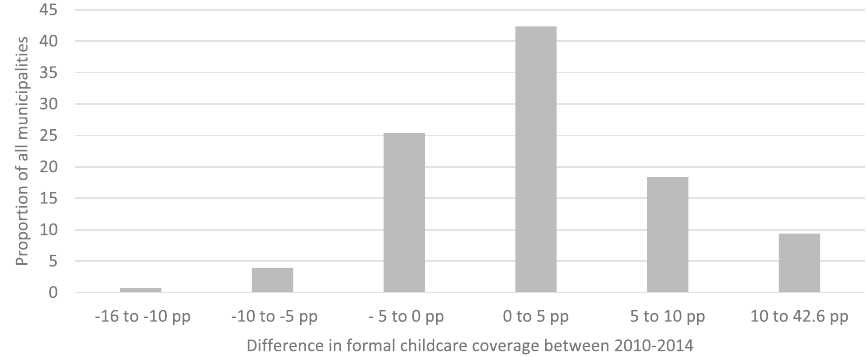
Fig. 2 Distribution of changes in formal childcare coverage between 2010 and 2014 within Belgian municipalities. Childcare coverage reflects the number of formal childcare places per 100 children aged 0–3 in each municipality (Source: K&G and ONE, calculations by authors)